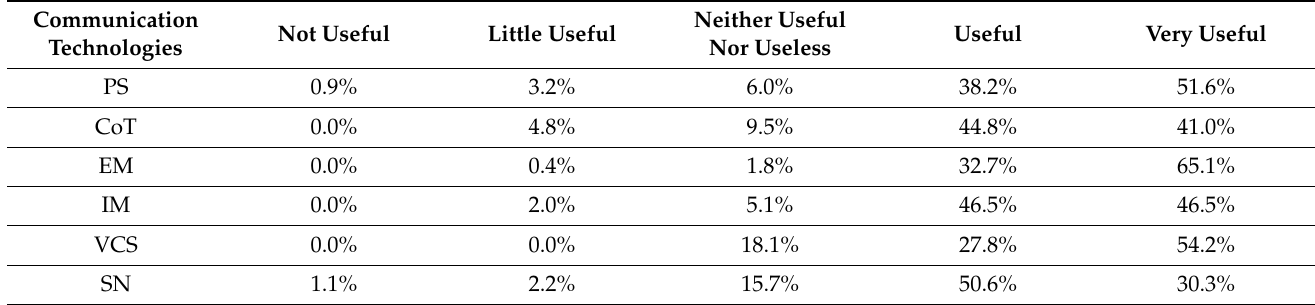
Table 7. Usefulness of the use of communication technologies by students.